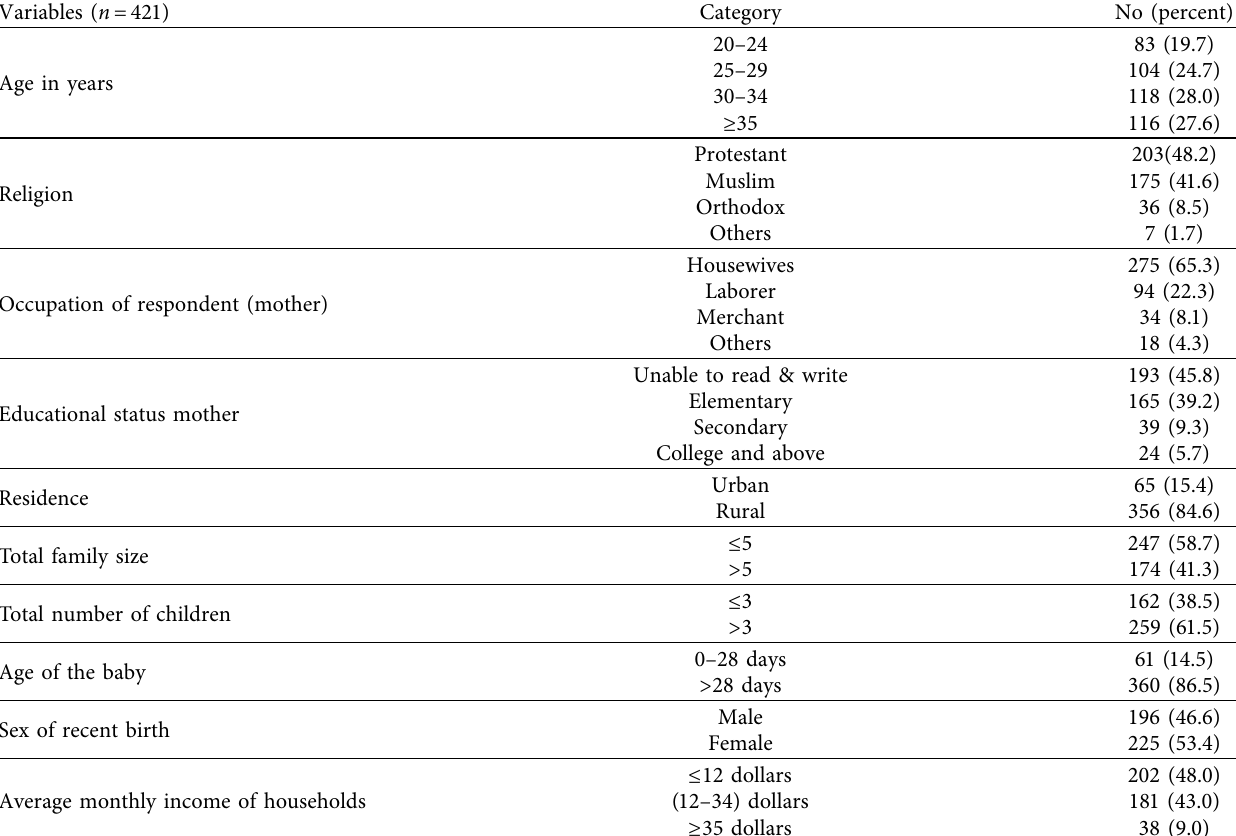
Table 2: Sociodemographic variables of mothers in Anlemo district, southern Ethiopia, 2019. Variables ( n �